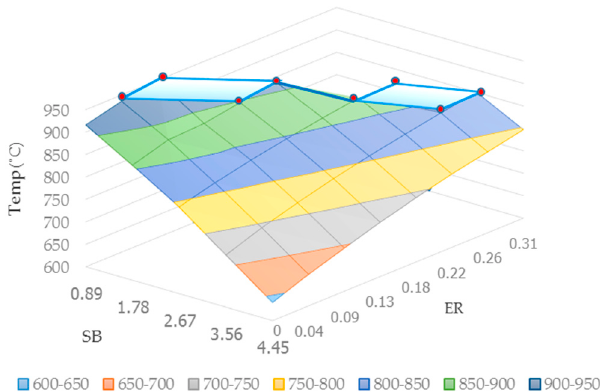
Figure 10. The relationship of key parameters for the energy self-sufficient condition.